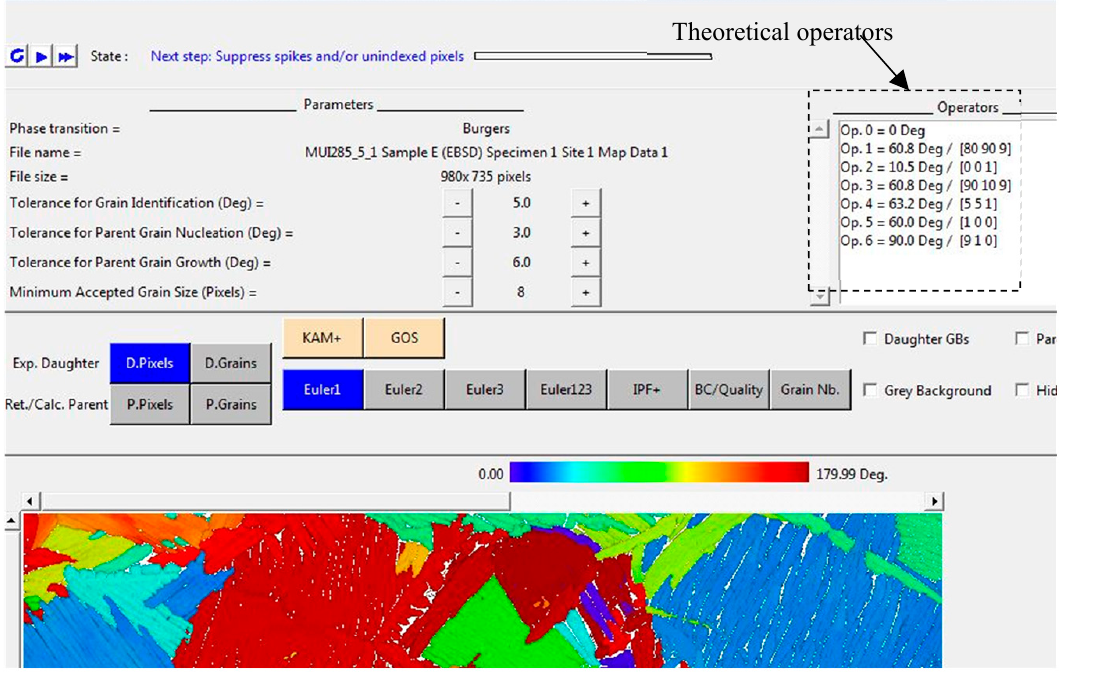
Figure 4. Typical ARPGE program main menu with set parameters for reconstruction of prior β -grains in Ti6Al4V (ELI).